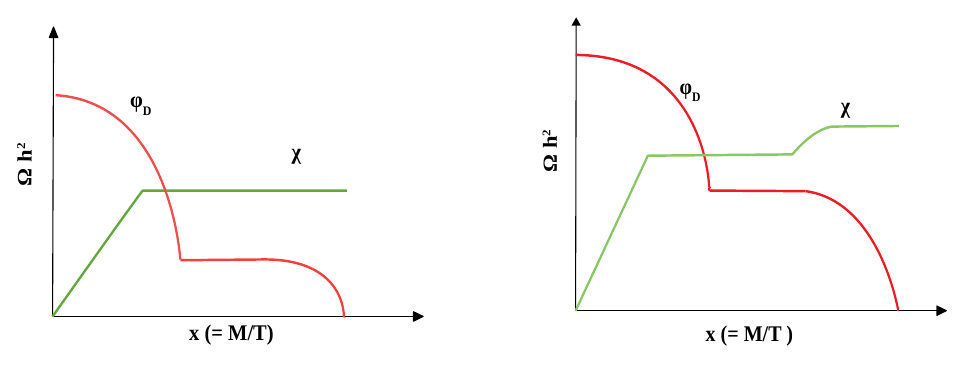
Figure 3 . Left panel: schematic diagram representing freeze-in dominated scenario. Right panel: schematic diagram representing super-wimp dominated scenario.